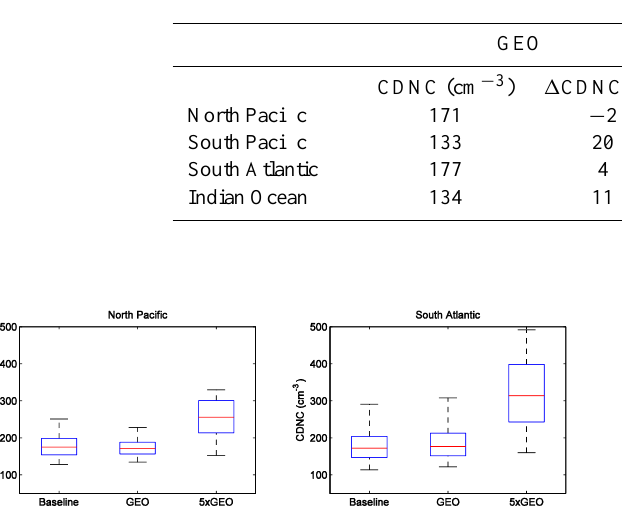
Table 1. Median CDNC concentrations and mean relative CDNC changes within the four geoengineered regions (indicated by red boxes in Fig. 2). The values are calculated from annual mean CDNC fields.